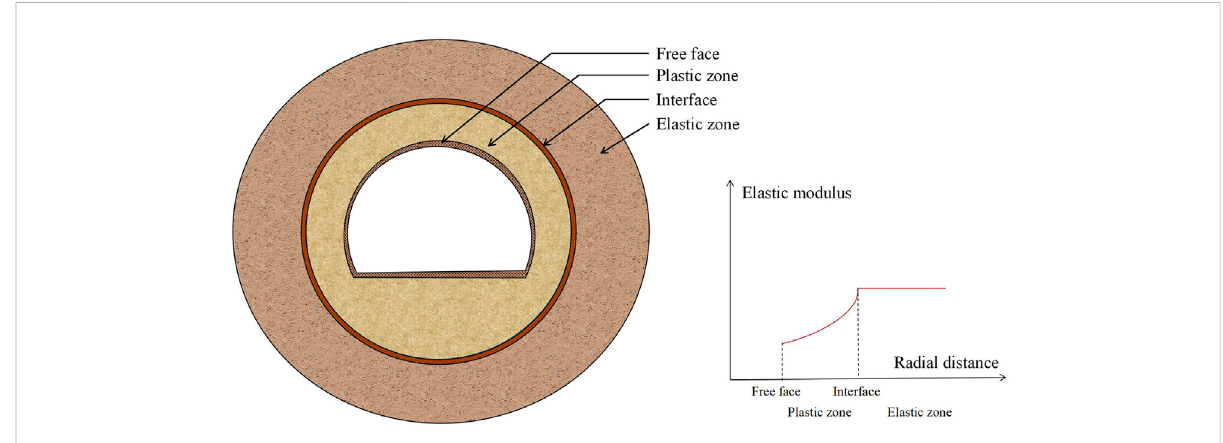
FIGURE 2 Elastic modulus distribution of the annular elastic-plastic zone of the surrounding rock in excavated